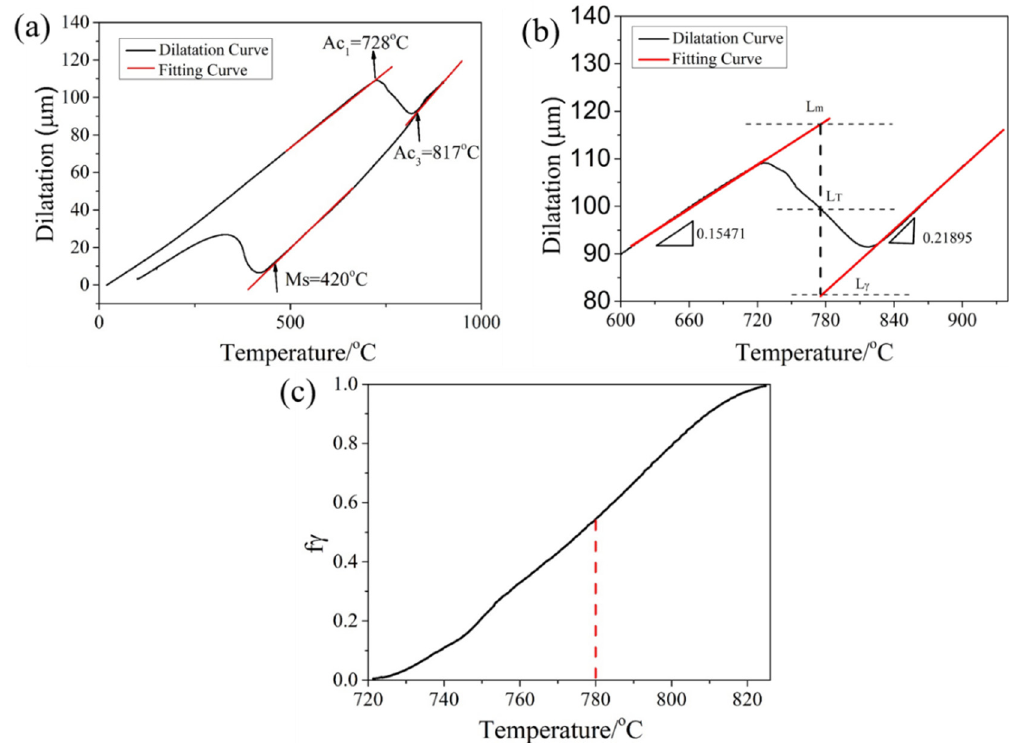
Figure 2. ( a ) Dilatational curve to obtain the martensite phase in the present steel after austenitization at 900 °C for 30 s. ( b ) Magnified view of dilatational curve during reverse transformation, demonstrating the application of lever rule in calculating the reverse transformation kinetics. ( c ) Reverse transformation kinetics during continuous heating under a heating rate of 10 °C/s.